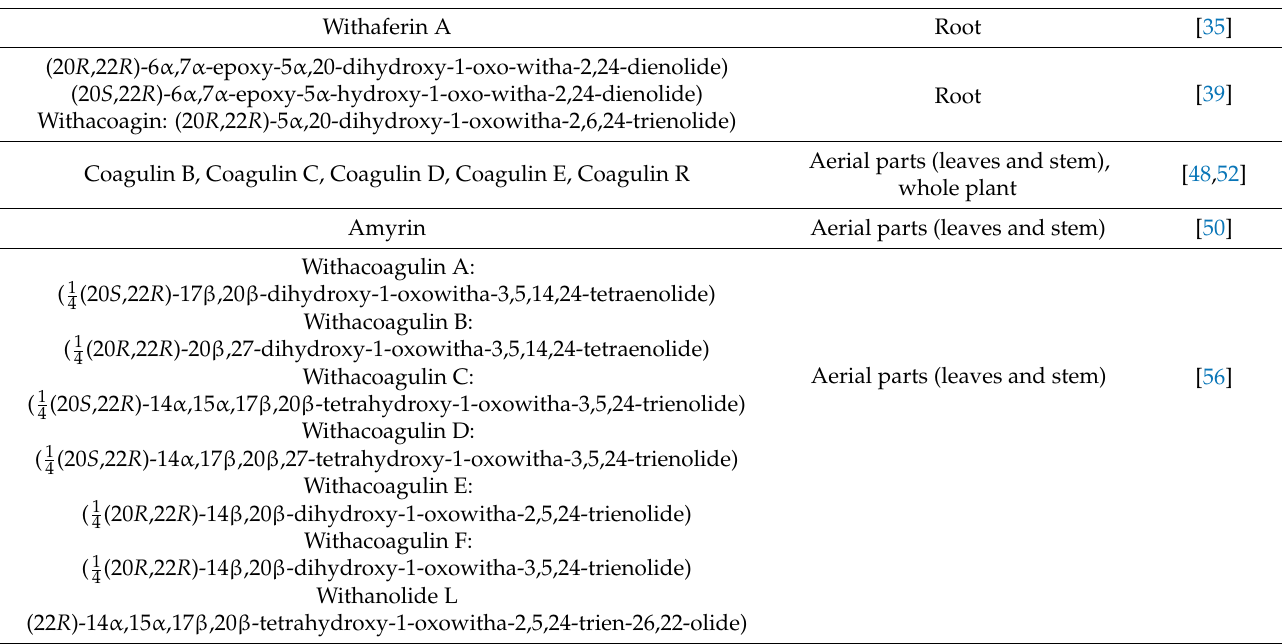
Table 2. Important constituents of roots, aerial parts, leaves, and fruits of W. coagulans.